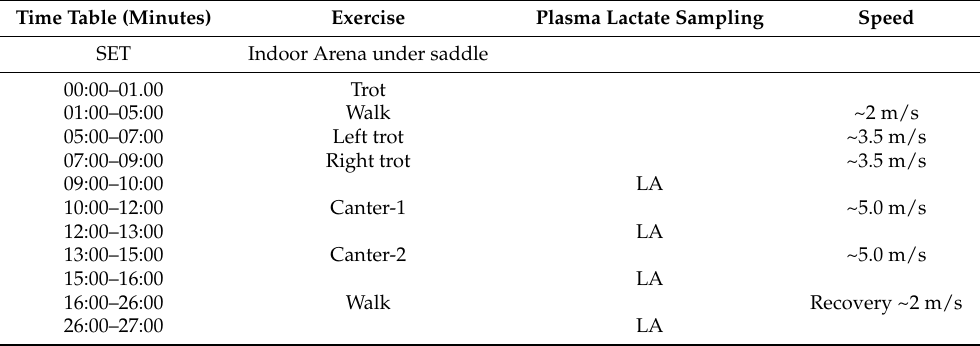
Table 1. Protocol of standardized exercise tests (SET) carried out in an in-door arena (20 × 60 m) by young Friesian horses, measuring heart rate (HR) and plasma lactate concentration